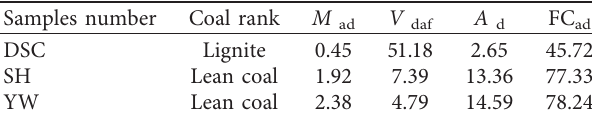
Figure 2: Parallel and vertical bedding direction coal samples. (a) Experimental coal samples. (b) The bedding direction. Table 1: Industrial analysis basic parameter.